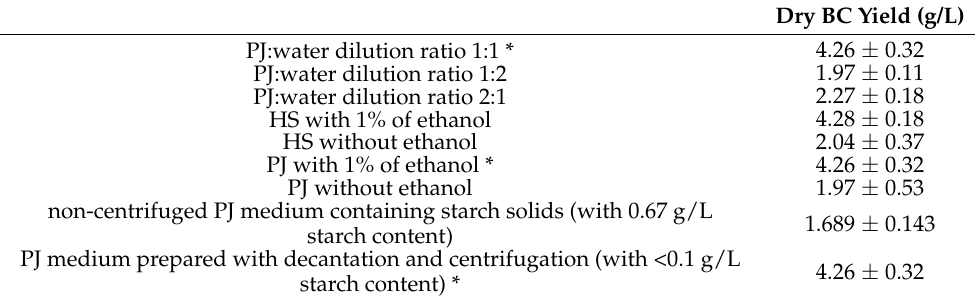
Table 1. Dry BC yield of K. xylinus ATCC 53524depending on the degree of potato tuber juice dilution with water, the addition of ethanol, and starch